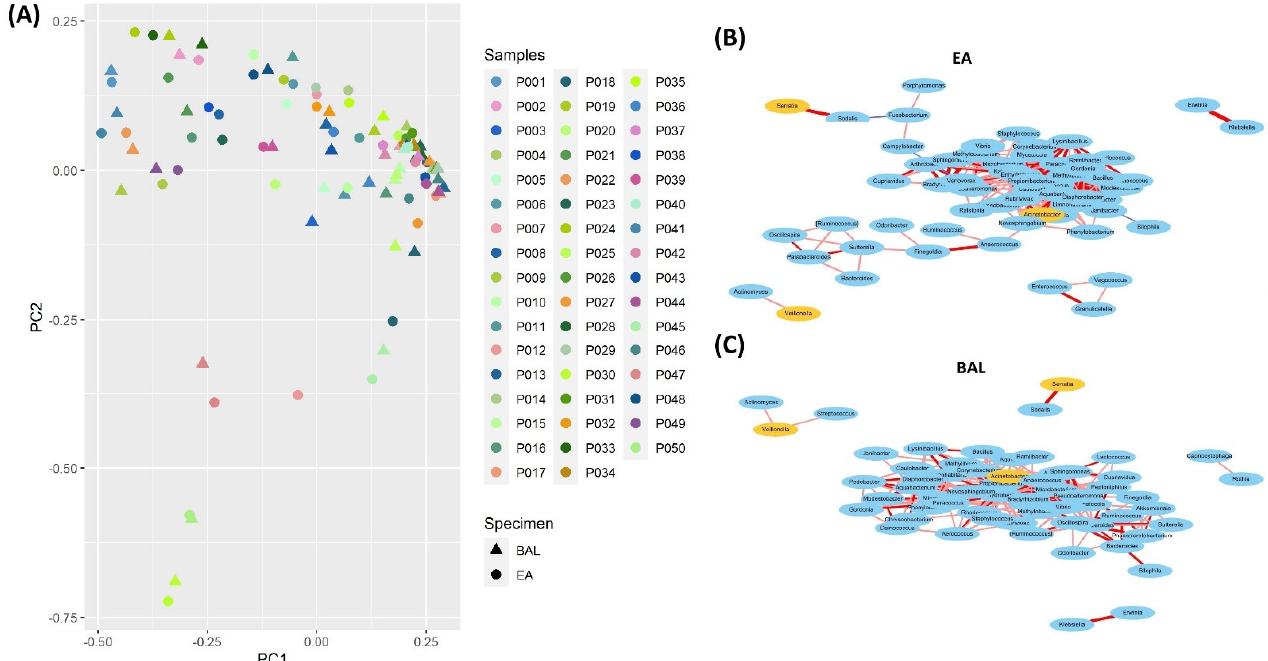
Figure 4. Microbial composition in the EA samples resembled that in the BAL samples for most patients. ( A ) Results of the Principal Coordinates Analysis (PCoA) of the 50 patients with CAP pairs using Bray-Curtis distance. ( B ) Counterbalances between the microbiota in the EA samples. ( C ) Counterbalances between the microbiota in the BAL samples.